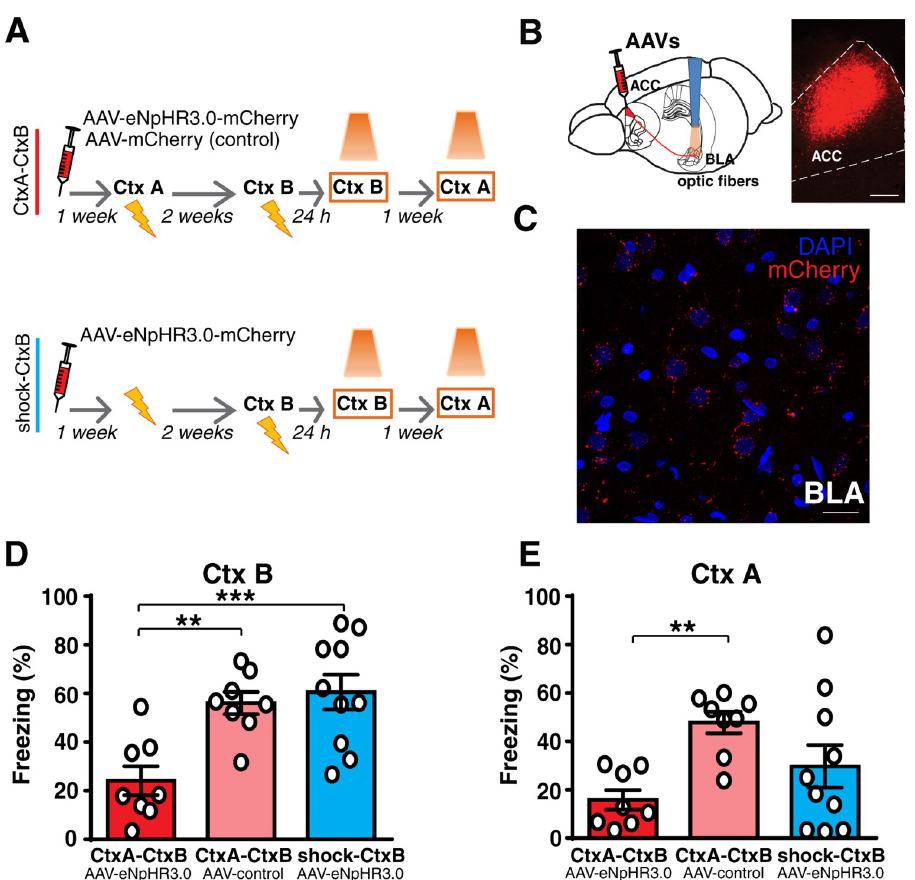
Fig 5. Prior contextual fear learning makes the ACC-to-BLA connectivity necessary for recent memory. (A and B) To investigate the involvement of the ACC descending pathway to the BLA in the retention of recent and remote contextual fear memories, the ACC was injected with rAAV5/CamKIIa-eNpHR3.0-mCherry-WPRE or rAAV5/ CamKIIa-mCherry-WPRE. Optic fibers were implanted above the BLA. (C) Representative micrograph showing the expression of AAV-mCherry in the ACC and its terminals in the BLA. Scale bars, 300 and 20 μ m, respectively. (D) The optogenetic inhibition of ACC axon terminals in the BLA affected the retention of recent fear memory only in animals that had undergone another contextual fear learning previously (1-way ANOVA, F (2,23) = 9.90, p = 0.0008, η 2 = 0.4628; Tukey: CtxA-CtxB eNpHR3.0-mCherry n = 8 vs. CtxA-CtxB control-mCherry n = 8, p = 0.0055; CtxA-CtxB eNpHR3.0-mCherry vs. shock-CtxB eNpHR3.0-mCherry n = 10, p = 0.0010; CtxA-CtxB control-mCherry vs. shock-CtxB eNpHR3.0-mCherry , p = 0.8629). (E) Freezing to another different context was lower in rats where this context was previously paired to the US (remote fear memory) (1-way ANOVA, F (2,23) = 5.269, p = 0.0131, η 2 = 0.3142; Tukey: CtxA-CtxB eNpHR3.0-mCherry vs. CtxA-CtxB control-mCherry p = 0.0098; CtxA-CtxB eNpHR3.0-mCherry vs. shock-CtxB eNpHR3.0-mCherry , p = 0.3203; CtxA-CtxB control-mCherry vs. shock-CtxB eNpHR3.0-mCherry , p = 0.1521), thus showing that optogenetic inhibition of the ACC-to-BLA pathway also affected the retention of remote memory. �� P < 0.01, ��� P < 0.001. All data are mean and SEM. The summary data for Fig 5 can be found in Supporting information in the file named S5 Data. ACC, anterior cingulate cortex; BLA, basolateral amygdala; US, unconditioned stimulus. hippocampus 1 h after learning (Fig 6A–6C). Hippocampal lesions caused a significant decrease in the freezing to the CtxB in both groups (Fig 6C). Because excitotoxic lesions might transiently interfere with the activity of brain regions outside the hippocampus, such as the ACC, we repeated this experiment by inactivating the dorsal hippocampus with CNQX to block local AMPA glutamate receptors and found amnesic effects in both groups (Fig 6D and 6E). These results showed that the hippocampus is necessary for the formation of new contex- tual memories, regardless of whether prior fear learning had occurred. Together with the above results, these data also indicate that, in animals that have learned a prior contextual fear